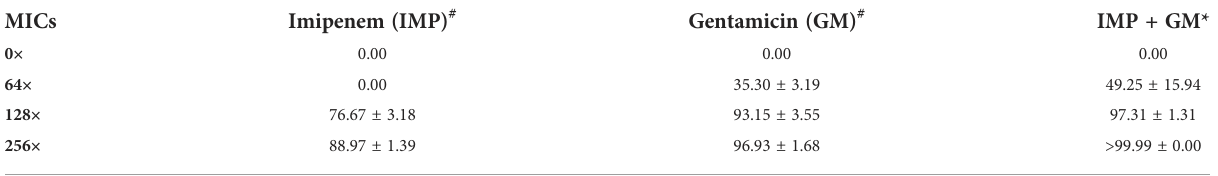
TABLE 2 Effects of different antibiotic doses on bio fi lm bacteria (bactericidal rate %, day 1 bio fi lms, 4-h treatments in vitro , mean ± SE). MICs